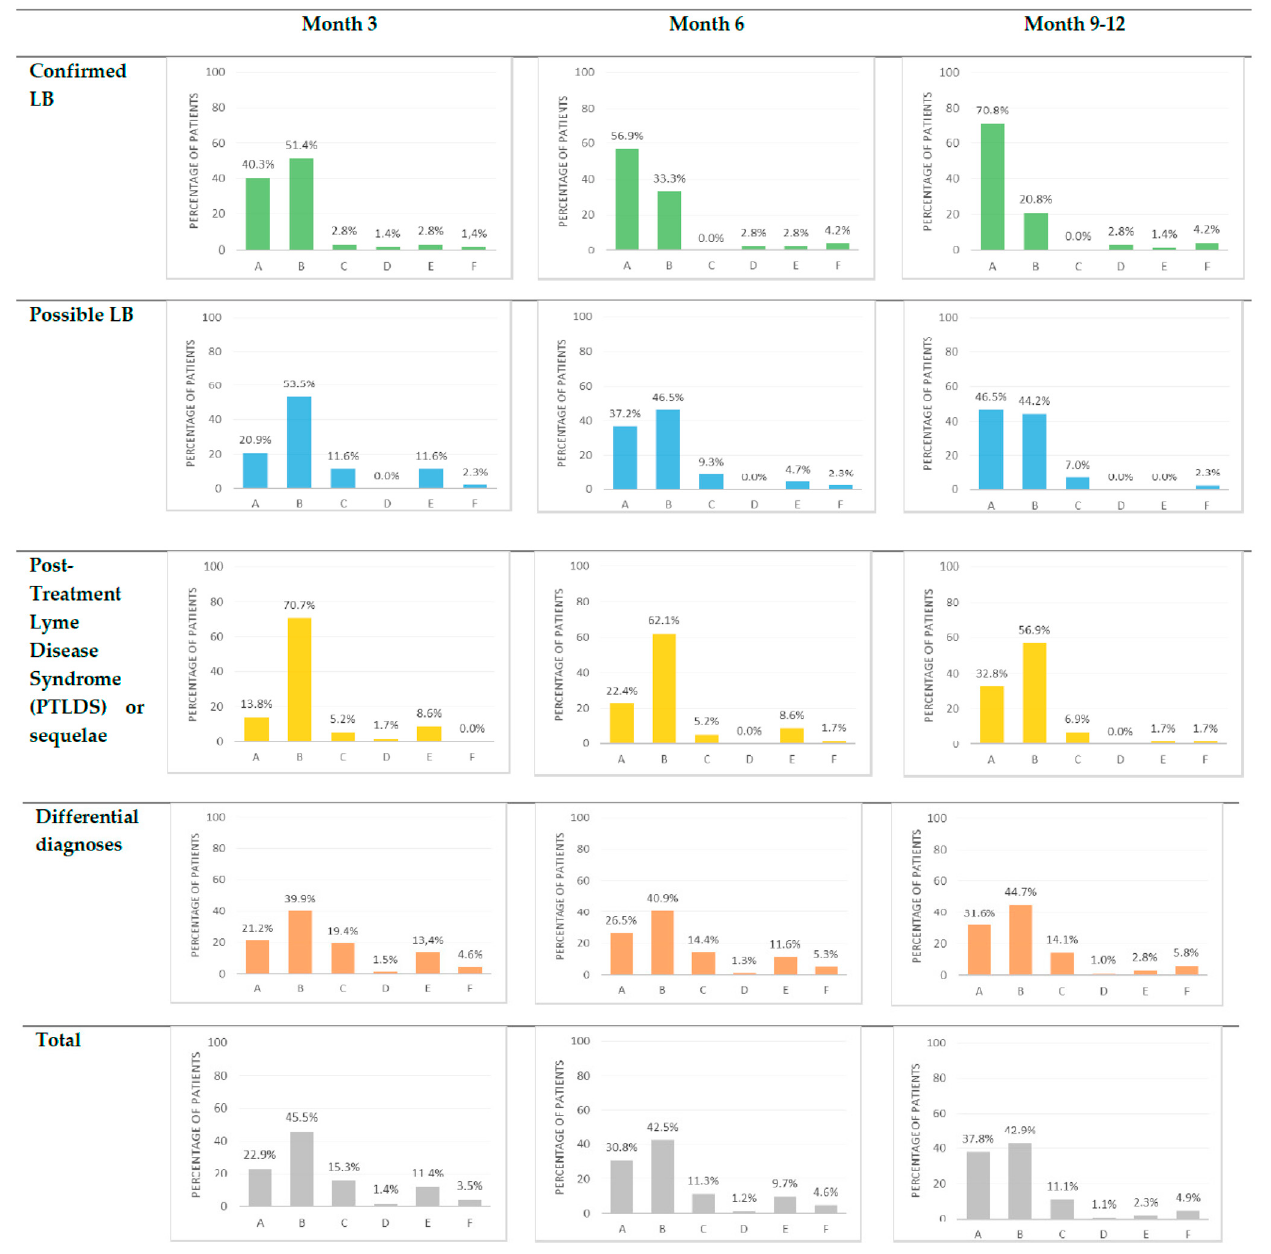
Figure 2. Clinical outcome of the patients consulting at TBD-RC of Paris and Northern region at three, six and 9–12 months. A = Recovery; B = Partial improvement; C = Stagnation; D = Deterioration; E = Unknown; F = Lost to follow